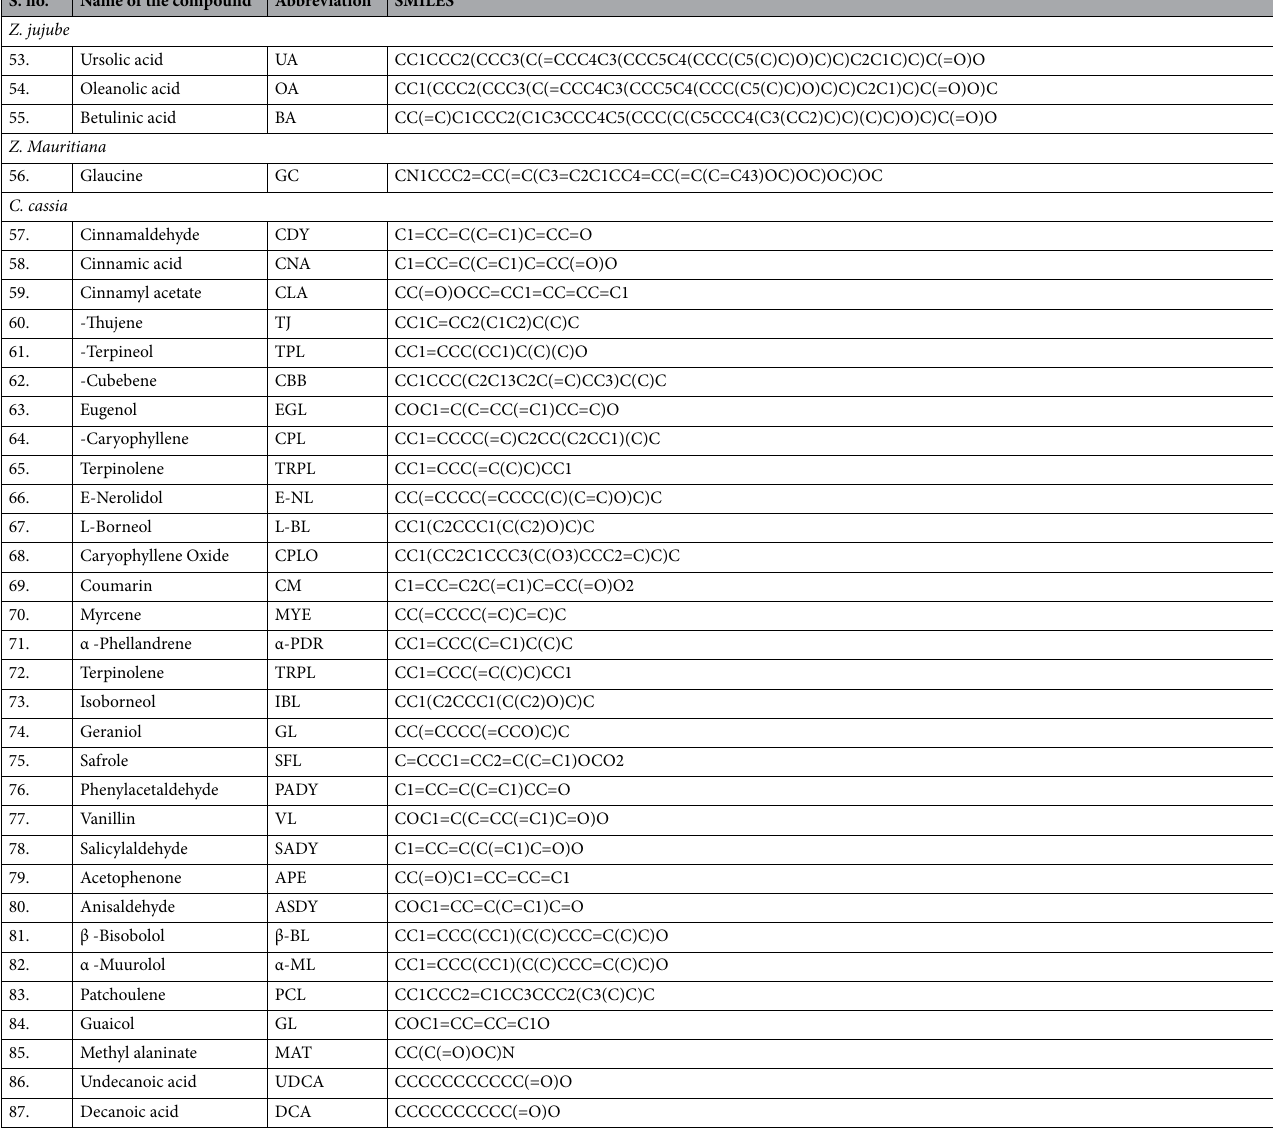
Table 1. List of Compounds with its Abbreviations &